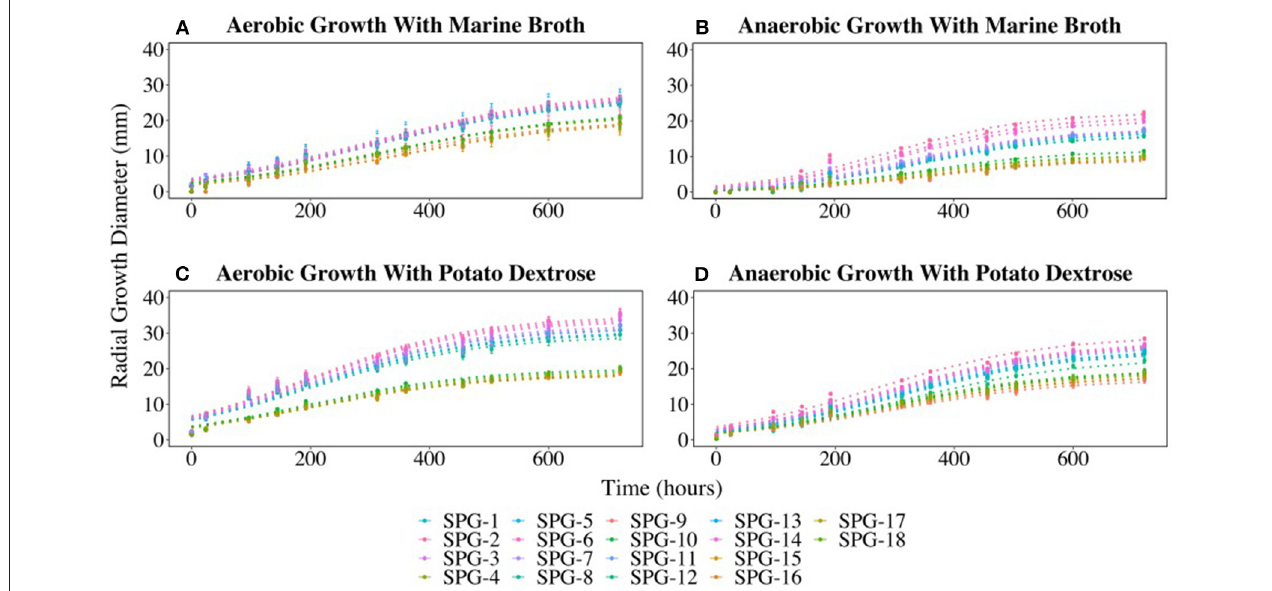
FIGURE 4 | Radial growth rates (in mm) of all isolates on marine broth agar (MBA) or potato dextrose agar (PDA) under oxic or anoxic conditions. (A) Aerobic growth with MBA. (B) Anaerobic growth with MBA. (C) Aerobic growth with PDA. (D) Aerobic growth with PDA. Error bars represent the standard error calculated for 12 biological